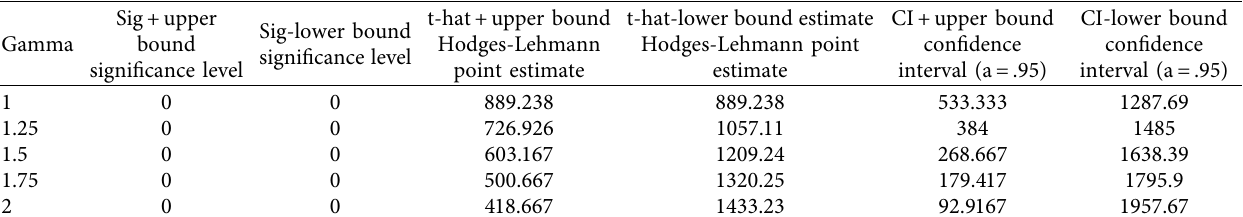
Table 4: Results of Sensitivity analysis using Rosenbaum bounds for wheat productivity. Rosenbaum bounds for Productivity ( N � 81 matched pairs).